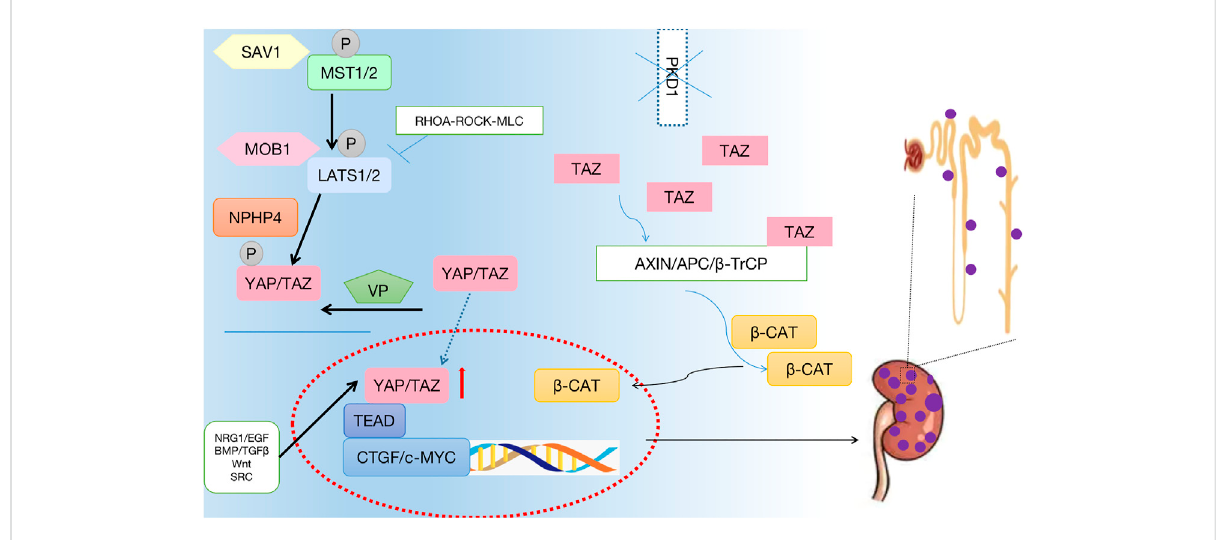
FIGURE 3 Crosstalk between the Hippo signaling pathway and the polycystic kidney disease. The phosphorylation of core protein MST1/2 and LATS1/ 2 was inhibited, and the phosphorylation level of downstream effector factor YAP was inhibited. YAP enters the nucleus, hippo pathway affects cell growth, proliferation, apoptosis. Thus, promoting the occurrence of polycystic